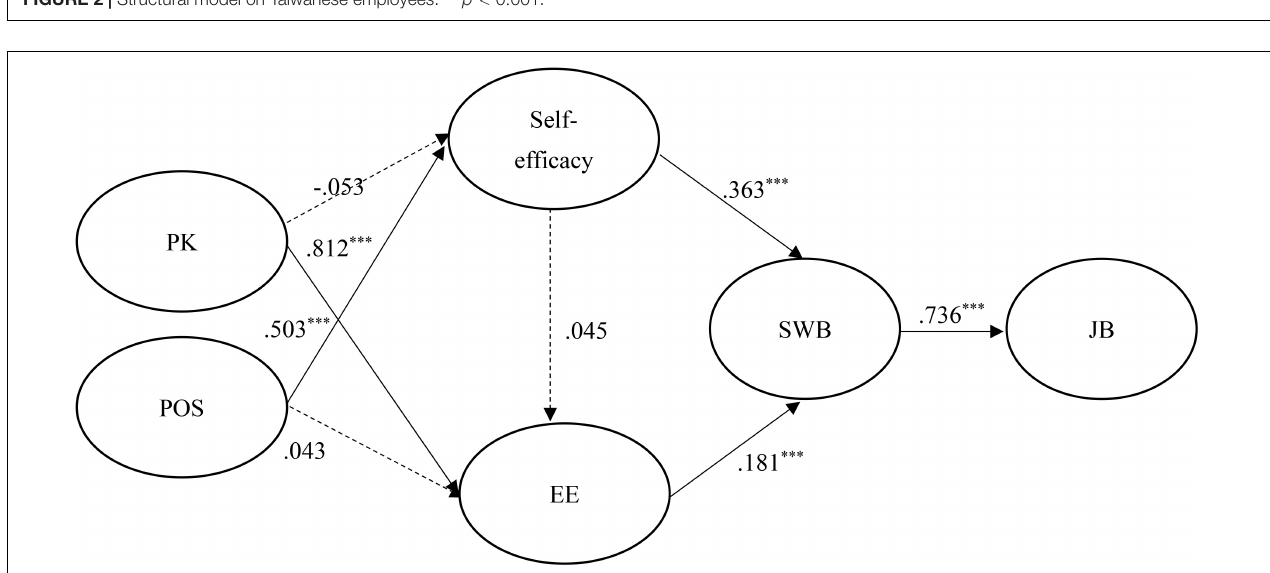
FIGURE 2 | Structural model on Taiwanese employees. *** p < 0 . 001.